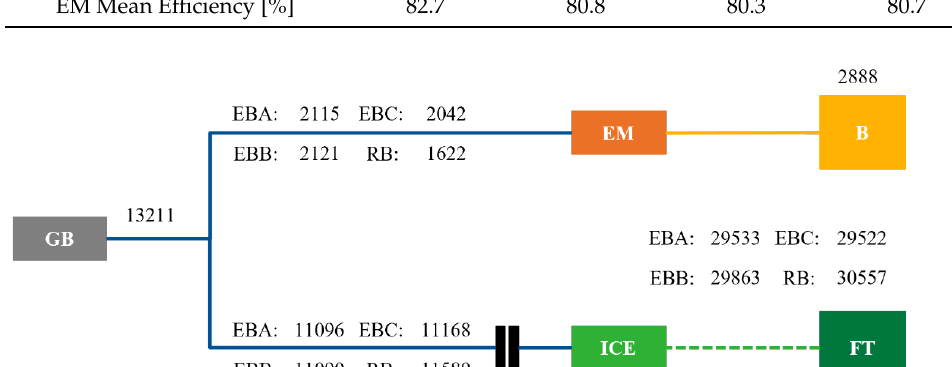
Figure 6. Net energy flows (kJ) for positive propulsion instances in WLTC for ECMS-Based Type A (EBA) algorithm, ECMS-Based Type B (EBB) algorithm, ECMS-Based Type C (EBC) algorithm and Rule-Based (RB) algorithm. ICE: Internal Combustion Engine, EM: Electric Motor, B: Battery and GB: Gearbox, FT: Fuel tank. Negative numbers correspond to energy loss.